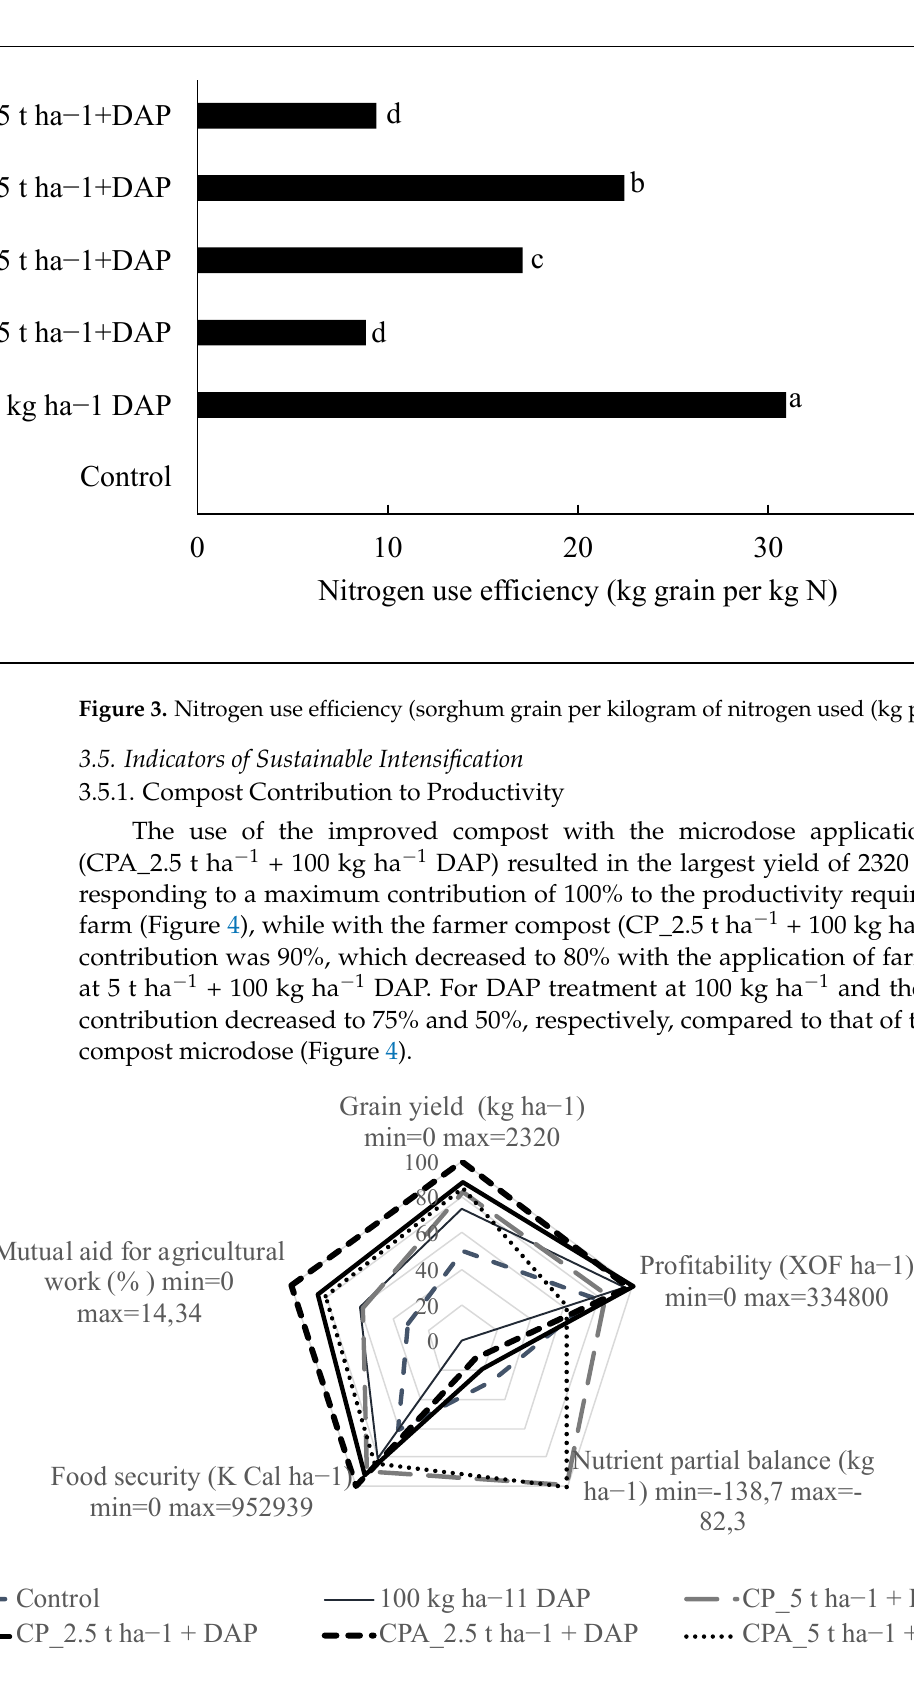
Figure 4. Sustainable intensification for compost application under sorghum production system in southern Mali.